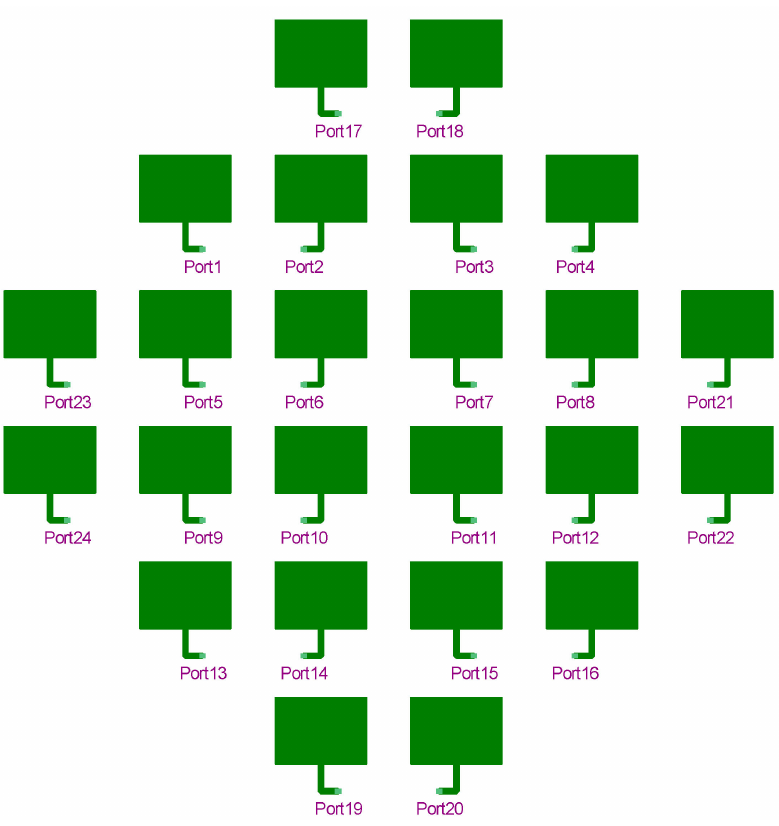
Figure 9. The 24 elements array